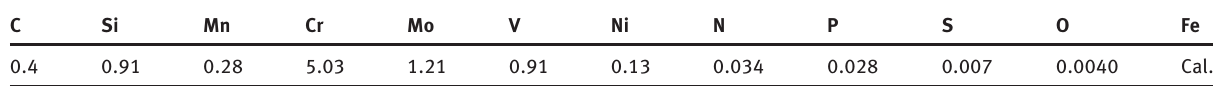
Table 1: Compositions of H13 die steel (wt%)